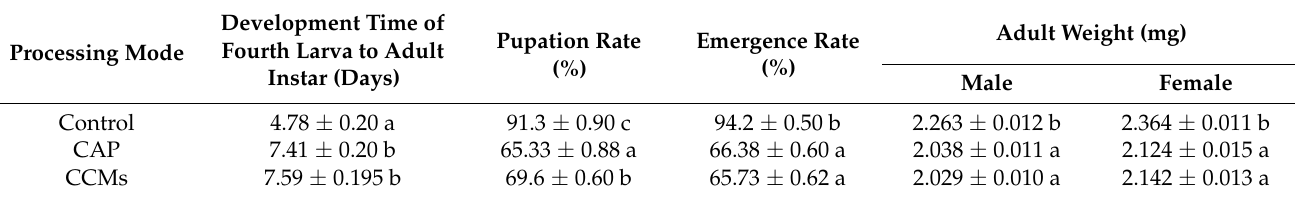
Figure 3. Changes in the mortality of the T. castaneum treated with CCMs ( a ) and CAP ( b ) at different concentrations. Data are expressed as mean ± SD ( n = 3). CAP, capsaicin; CCMs, capsaicin/chitosan microcapsules. Table 1. Effects of the CCMs and CAP on T. castaneum larval development.